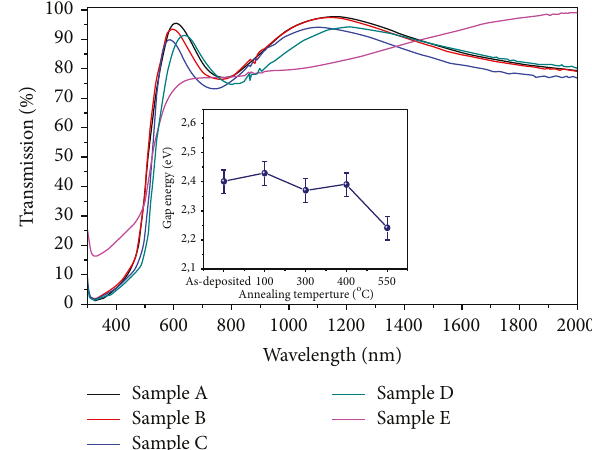
Figure 8: UV-Vis transmission spectra and the gap energy of as-deposited (sample A) and annealed CdS thin fi lms (samples: B, C, D, and